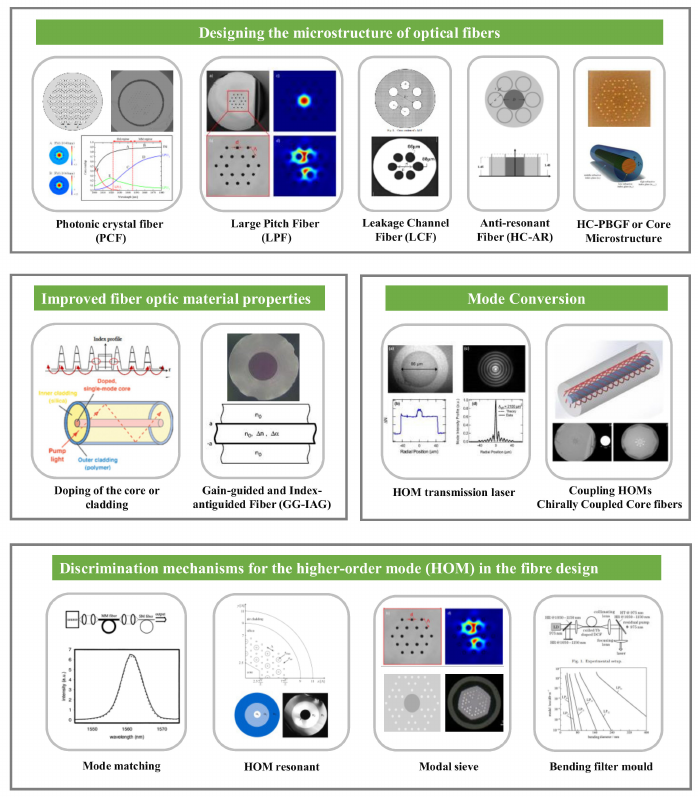
Figure 8. Technical routes [11,39,58,64,71–81] to achieve single-mode large field area for